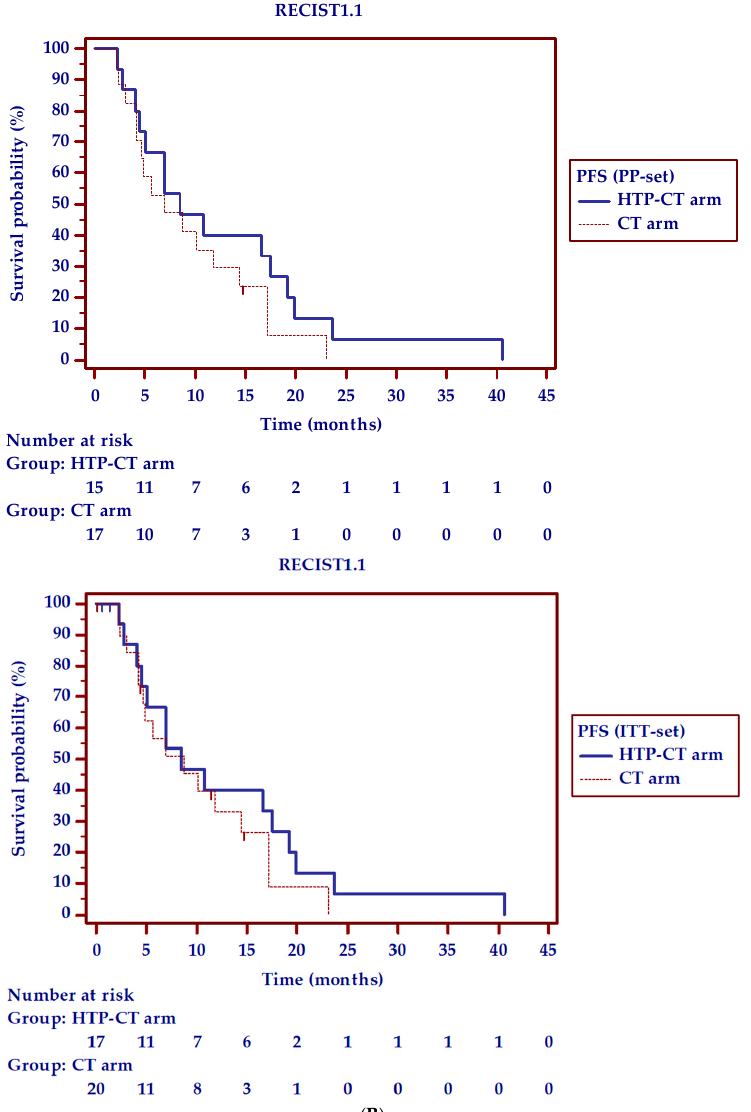
Figure 2 . Median progression-free survival (PFS) time (95% confidence interval) and hazard ratio (HR, 95% confidence interval) for progression in patients treated with endoscopic ultrasound-guided ablation with HybridTherm Probe plus chemotherapy (HTP-CT arm) versus chemotherapy alone (CT arm), according to: ( A ) Choi criteria. Per-Protocol (PP-set): 11.1 (4.0– 0.6) versus 8.7 (3.0–23.1) months; HR CT arm/HTP-CT arm for progression = 1.26 (0.6–2.6) (Log-rank test: Chi- squared = 0.41; p = 0.52); Intention-To-Treat (ITT-set): 11.1 (4.0–40.6) versus 9.4 (4.1–23.1) months; HR CT arm/HTP-CT arm for progression = 1.16 (0.6–2.3) (Log-rank test: Chi-squared = 0.17; p = 0.68). ( B ) RECIST1.1. Per-Protocol (PP-set): 12.6 (4.0–40.6) versus 9.6 (4.1–23.1) months; HR CT arm/HTP-CT arm for progression = 1.36 (0.7–2.8) (Log-rank test: Chi-squared = 0.72; p = 0.39); In- tention-To-Treat (ITT-set): 12.6 (4.0–40.6) versus 10.2 (4.2–23.1) months; HR CT arm/HTP-CT arm